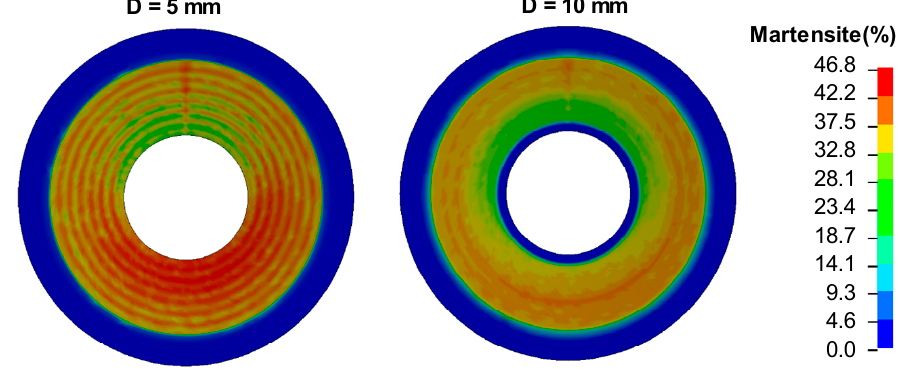
Figure 17. Comparison of the martensite content on the bottom surface of the disc springs for different tool diameters.